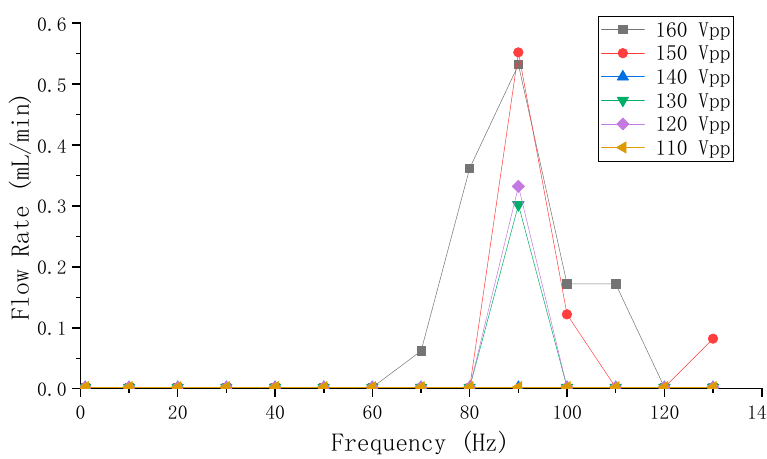
Figure 8. The flow rate measuring results of Group A PZT pumps.